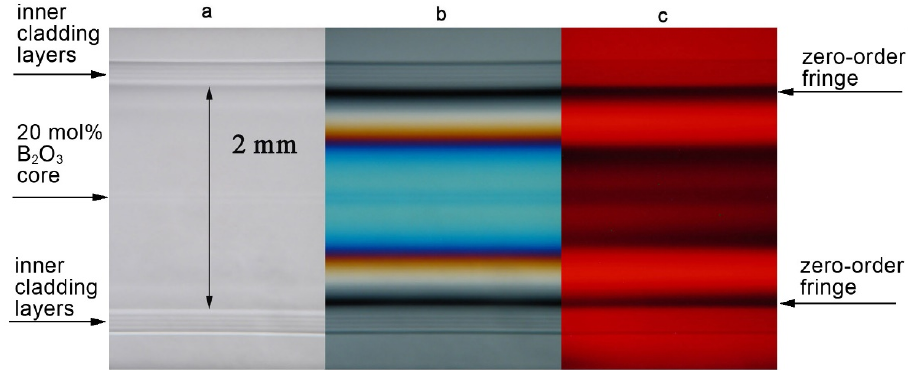
Figure 4. Photographs of the BS preform (for stress elements in panda-type fibers) taken in various conditions with the use of an optical microscope. Side view. ( a ) Transmitted white light optical image. Inner cladding layers are visible. ( b ) Transmitted white light optical image with crossed polarizers. Qualitative picture of stresses in the core. ( c ) Transmitted red light optical image with crossed polarizers. At the center of the core, the phase difference is about ~1.5 fringes.